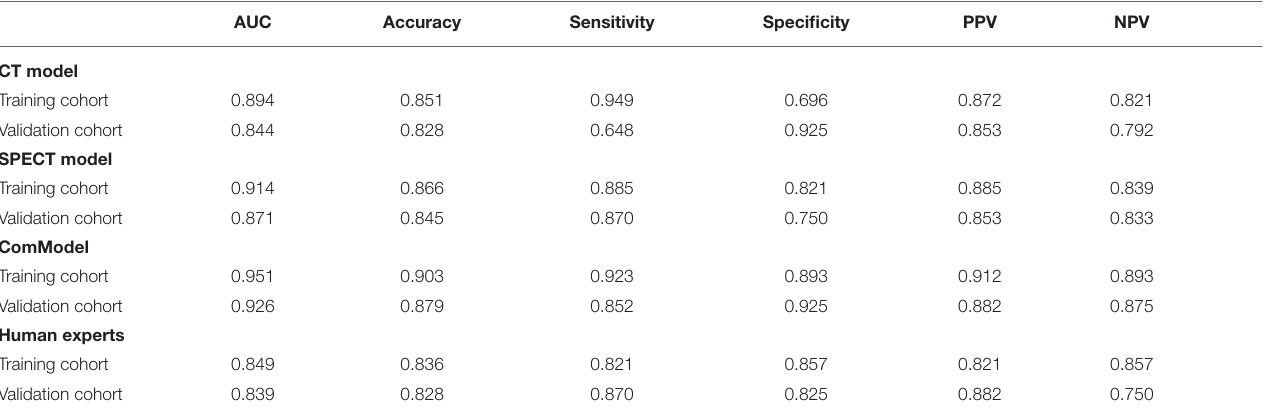
TABLE 2 | The diagnostic ability of each model for discriminating vertebral bone metastases from benign bone lesions. AUC Accuracy Sensitivity Specificity PPV